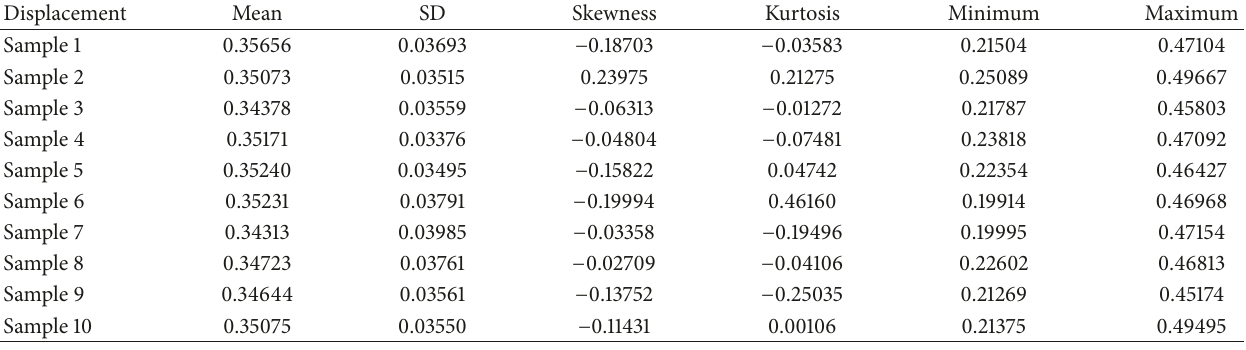
Table 8: Statistics of 10 samples parameters of the single high tower top node 35# Ux displacement time history under wind field 2 (m).